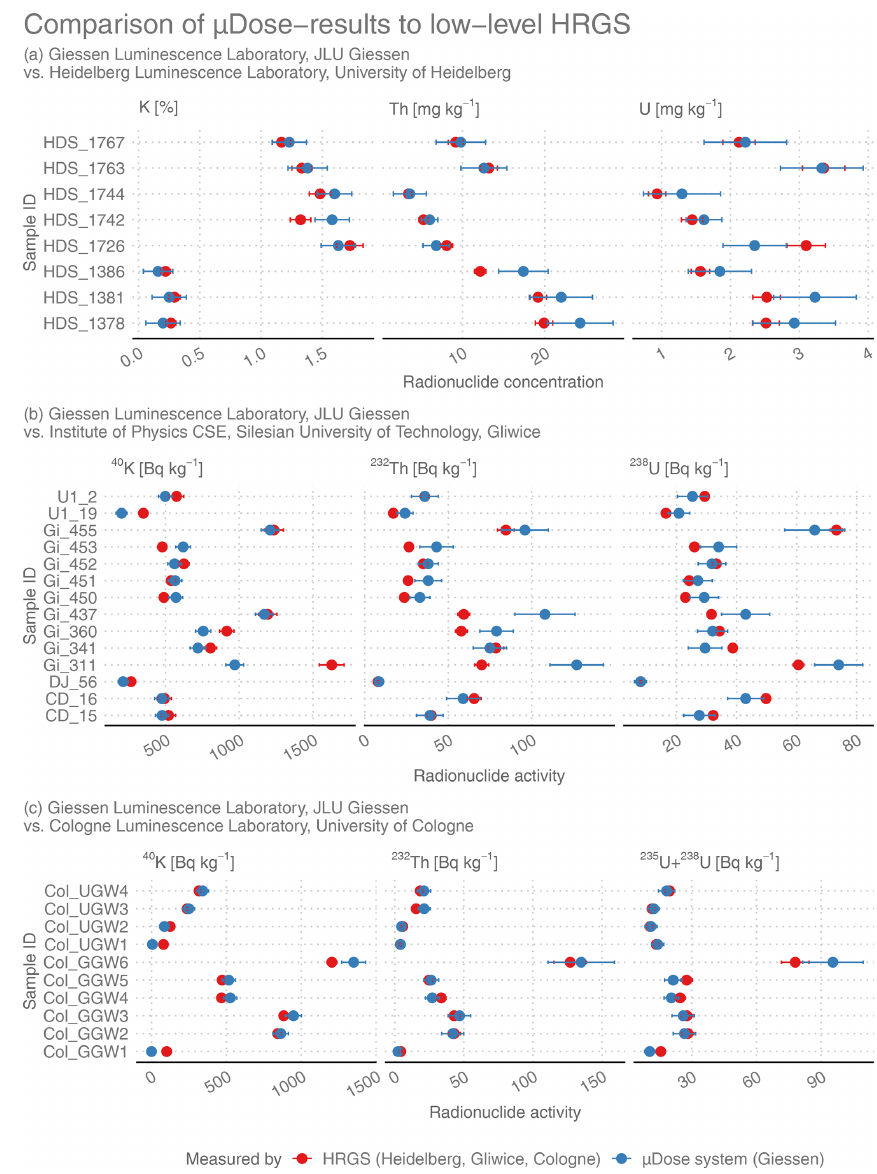
Figure 9. Comparison of results obtained by HRGS in different laboratories (red symbols) to the findings derived from µ Dose measurements (blue symbols). (a) Samples provided by the Heidelberg Luminescence Laboratory. Please note that these values are given as concentrations (% for K; mgkg − 1 for U and Th). For Gliwice and Cologne laboratories values are given as activities (Bqkg − 1 ). Only the 238 U-specific activity is shown for the samples measured in the Gliwice laboratory (b) , while the combined activity of 235 U and 238 U is depicted for the samples from Cologne (c)